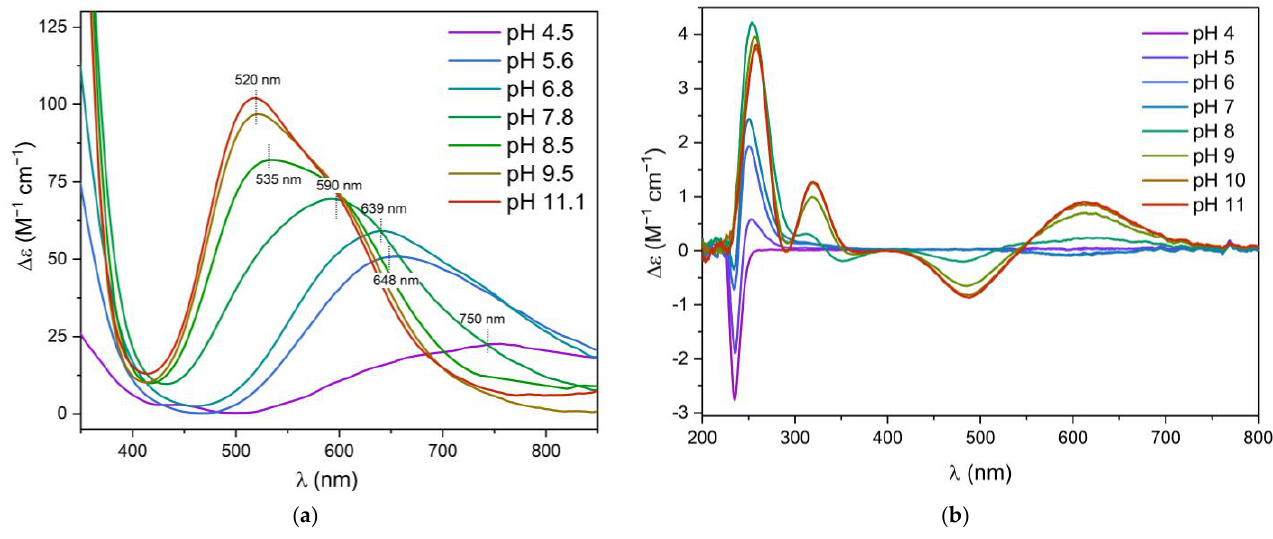
Figure 2. ( a ) Vis absorption spectra and ( b ) CD spectra of Cu 2+ complexes with L2 at different pH values; M:L ratio 0.8:1. C M = 0.63 × 10 − 3 M, optical path 1 cm. The wavelength of maximum absorption is reported for each Vis absorption spectrum.